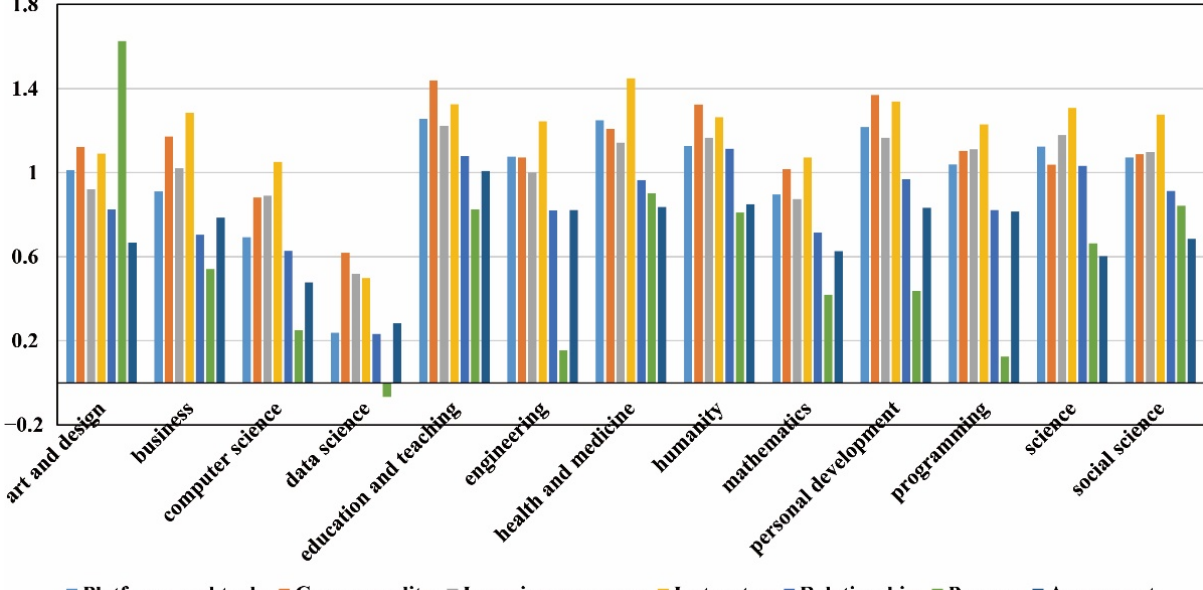
Figure 4. Averaged sentiment scores for each topic in different subjects (calculated based on “syuzhet”).